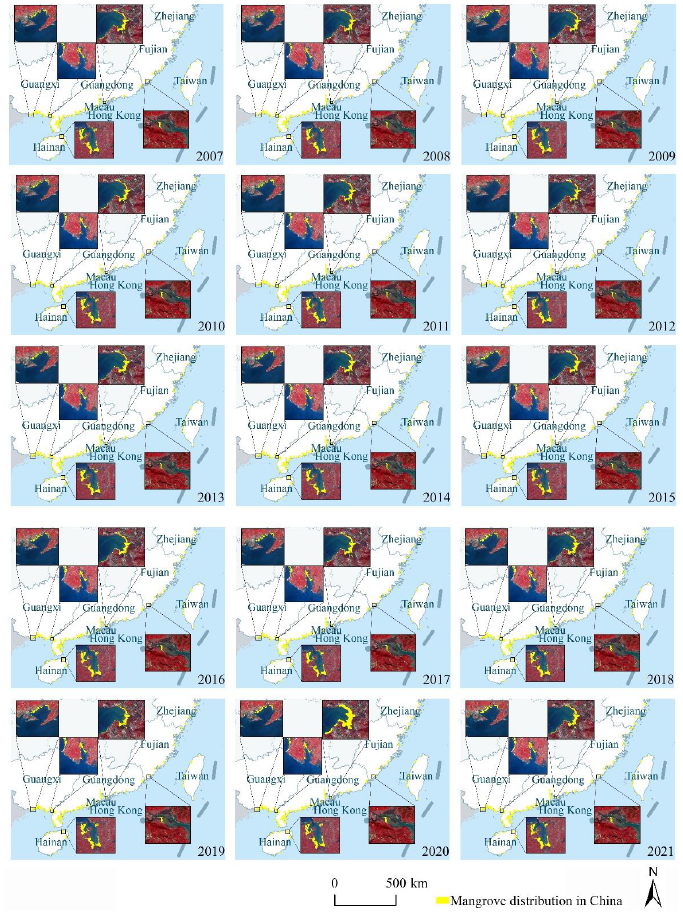
Figure 4. Mangrove distribution in China during 1986 – 2021.